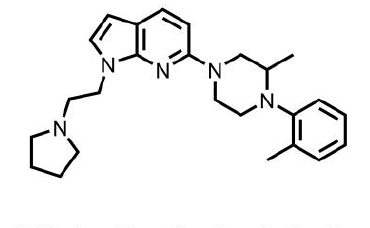
Figure 6. STING inhibitor with an unknown site of action.